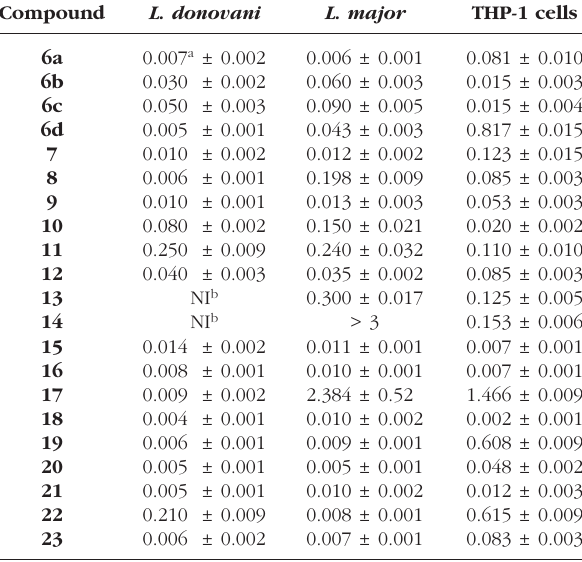
Table II. – IC50 (µM) of quinonic compounds 6-23 against Leishma- nia donovani (MHOM/ET67/L82:LV9), L. major (MHOM/PT/92/CRE26) and human myelomonocytic cell line, THP-1